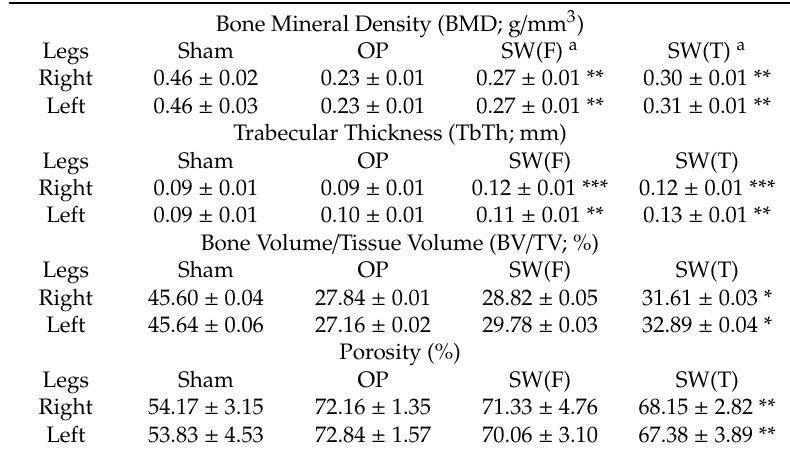
Table 2. Both VOI regions of the right and left tibias for bone mineral density (BMD), trabecular thickness (TbTh), bone volume / tissue volume (BV / TV), and porosity of ovariectomized (OVX) rats in the Sham, OP, SW(F), and SW(T) groups by micro-CT